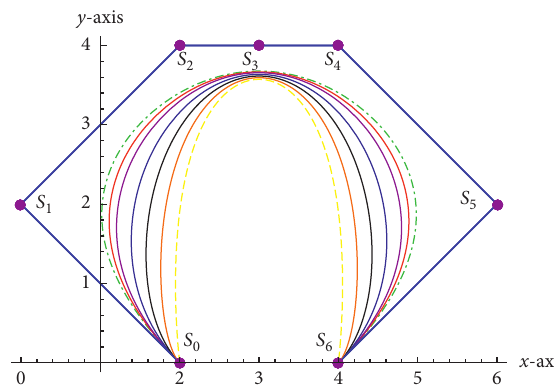
( η ) and f ( η ) on η ∈ [ 0 , π /2 ] . 1 2